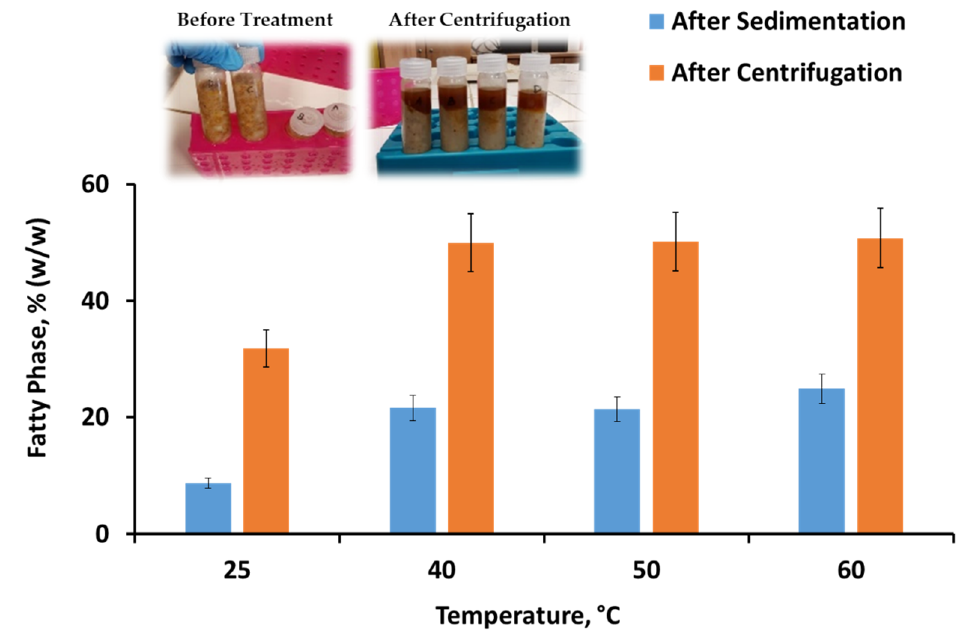
Figure 1. Separation of the fatty phase after incubation at various temperatures followed by sedimentation for 15 min or centrifugation for 5 min, 1500 rpm, 25 °C. In the inset—photo of samples before and after separation.